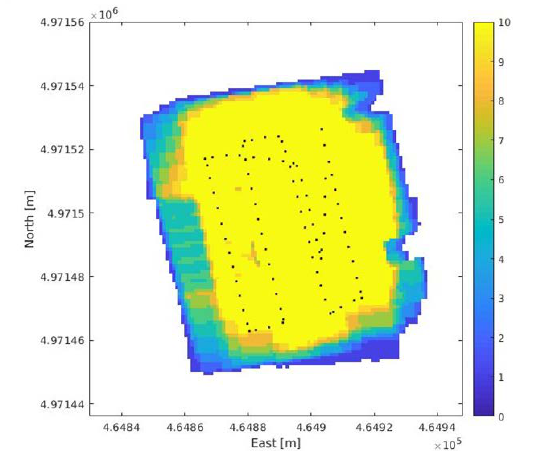
Figure 5. Camera location of the nadiral survey (black dots) and image overlapping (colour bar).